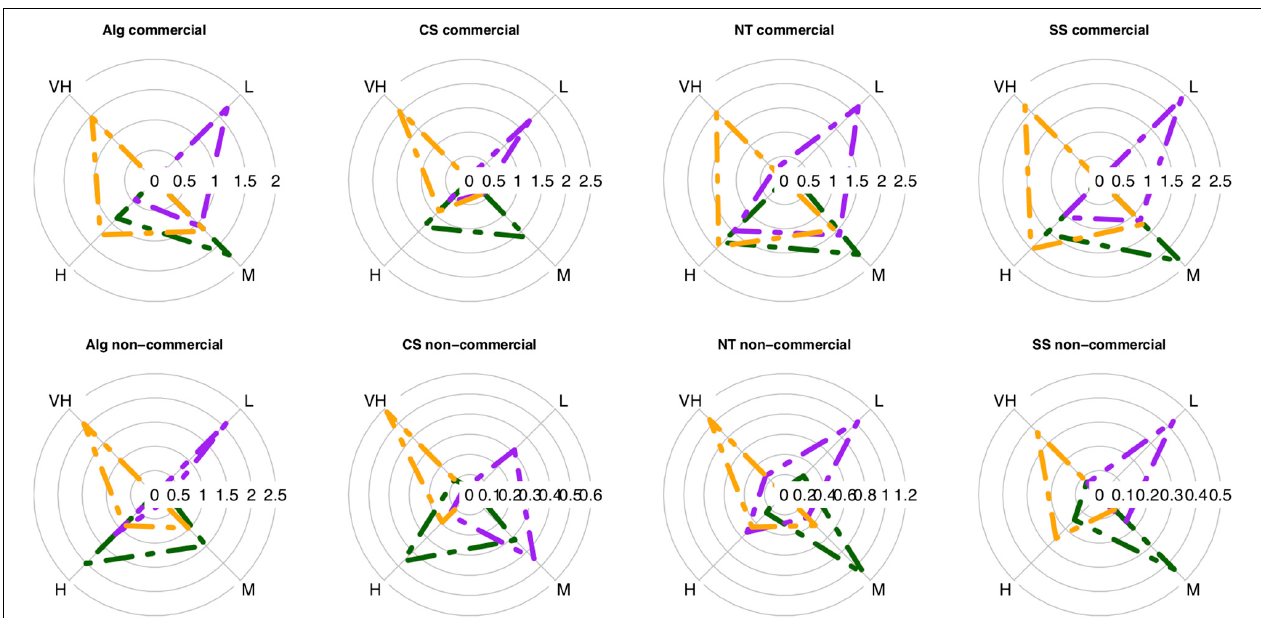
FIGURE 3 | Average biomass of the four vulnerability groups (L, low; M, moderate; H, high; VH, very high) per sub-index: catchability (dark green), resistance (purple), resilience (orange) in each case study: Alg, Algarve; CS, Catalan sea; NT, Ligurian-North Tyrrhenian Sea; SS, Strait of Sicily. The first row illustrates the average vulnerability biomass of the commercial fraction and the second row illustrates the non-commercial fraction. Data as average biomass [log10 (biomass + 1)]